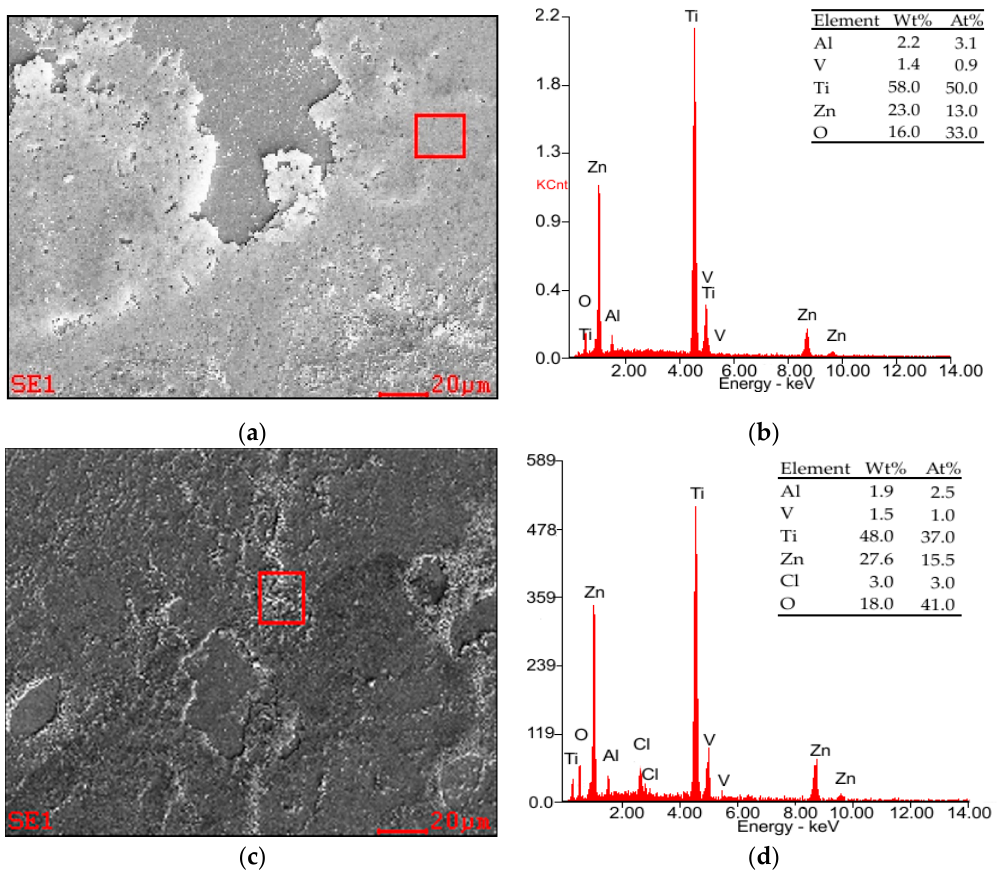
Figure 9. Examples of SEM observations of the M2 sample group ( a ) sponge-like corrosion products; ( b , c ) corrosion products in form of laminar crystals ( d ) energy-dispersive X-ray spectroscopy (EDS) results for marked area in Figure 9c.